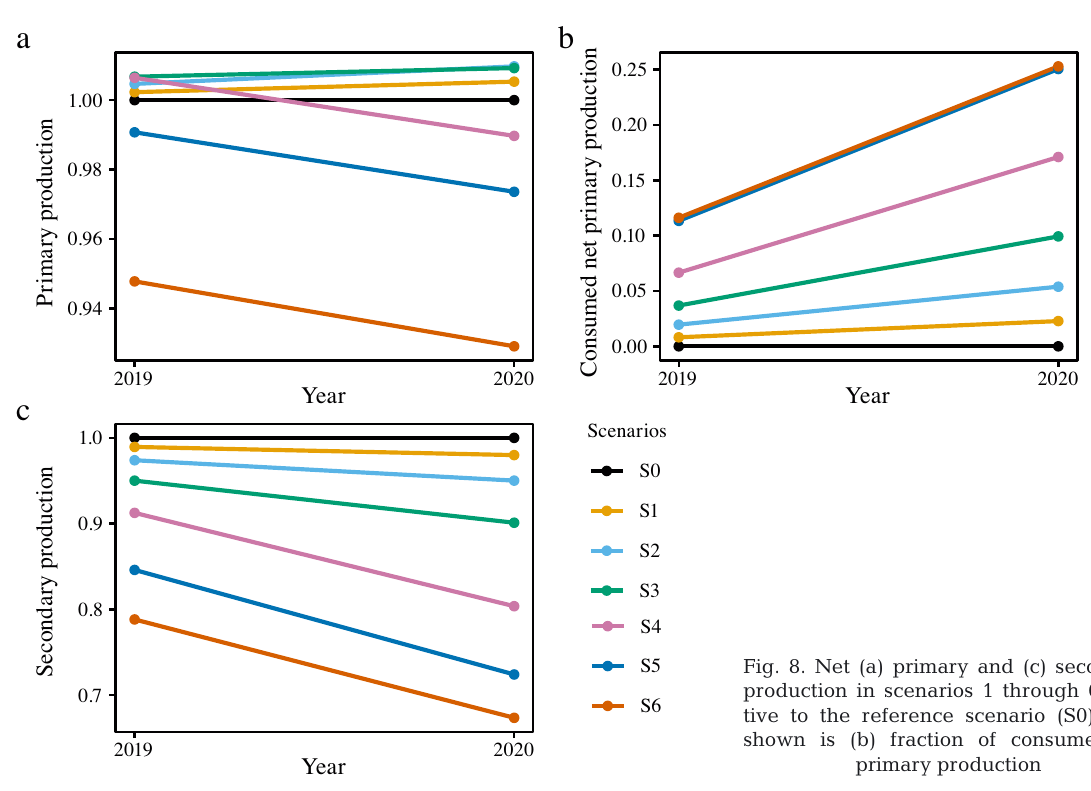
total of 89 kt of carbon within the annotated box in Fig. 1. Even though NPP remained relatively un - changed, mussel feeding depleted up to 50−60% of tion for feed and human consumption in S4 and S5